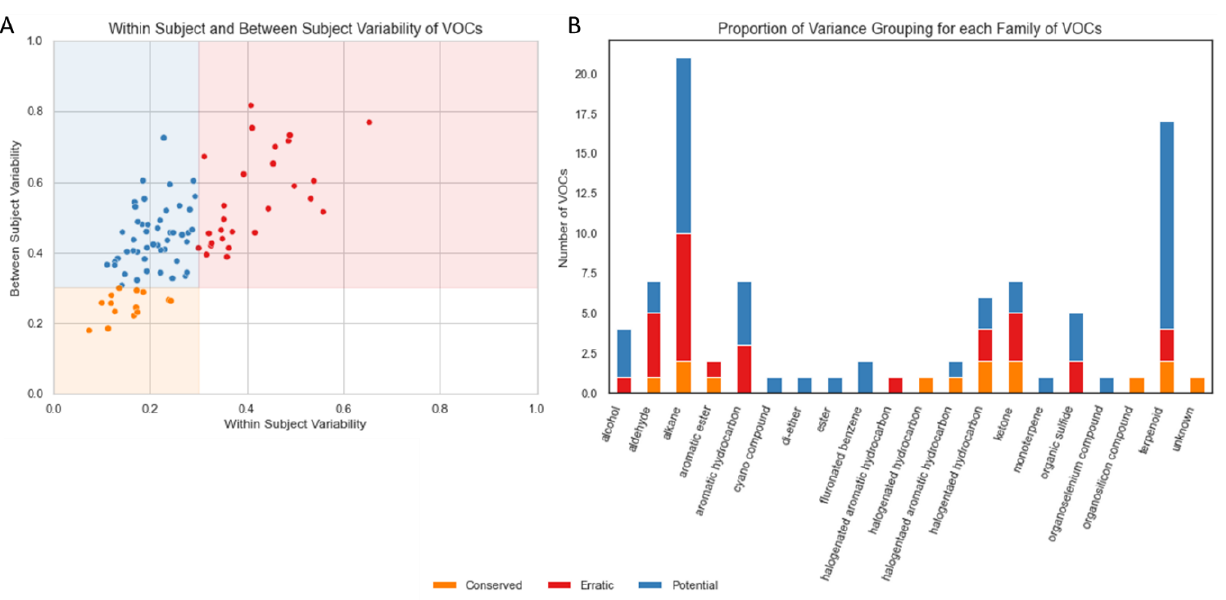
Figure 2. ( A ) Scatterplot of within-subject variability and between-subject variability for each VOC. ( B ) Barplot indicating the frequency of VOC type observed in the NIST (National Institute of Stand- ards and Technology) -identified VOCs used in this analysis, coloured by the relative frequency of repeatability categories derived from within- and between-subject measures. Volatile organic compounds (VOCs), National Institute of Standards and Technology